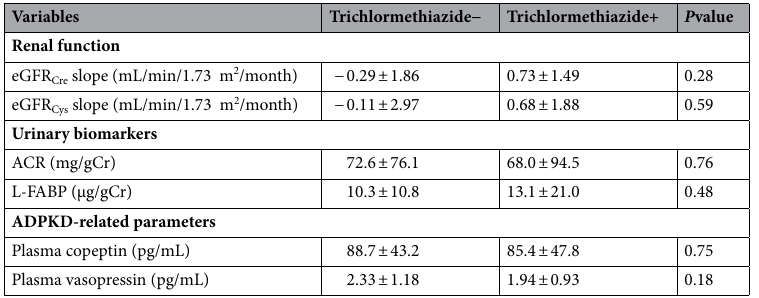
Table 4. Effect of trichlormethiazide on renal outcomes. For urinary biomarkers, the mean values at 4, 8, and 12 weeks of each trial were calculated. eGFR estimated glomerular filtration rate, Cre creatinine, Cys cystatin C,